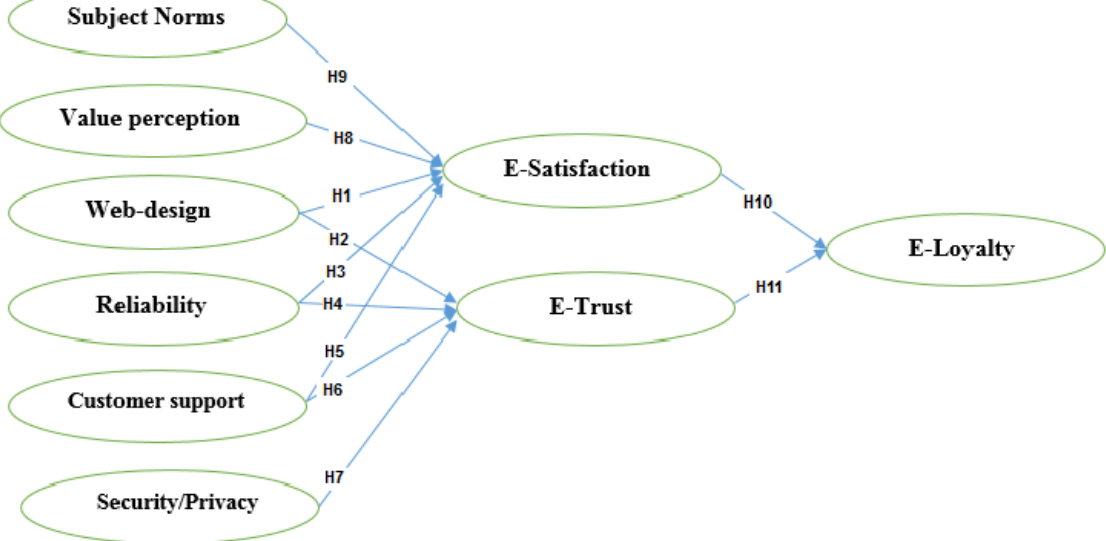
Fig. 1: The Conceptual Model of E-Banking